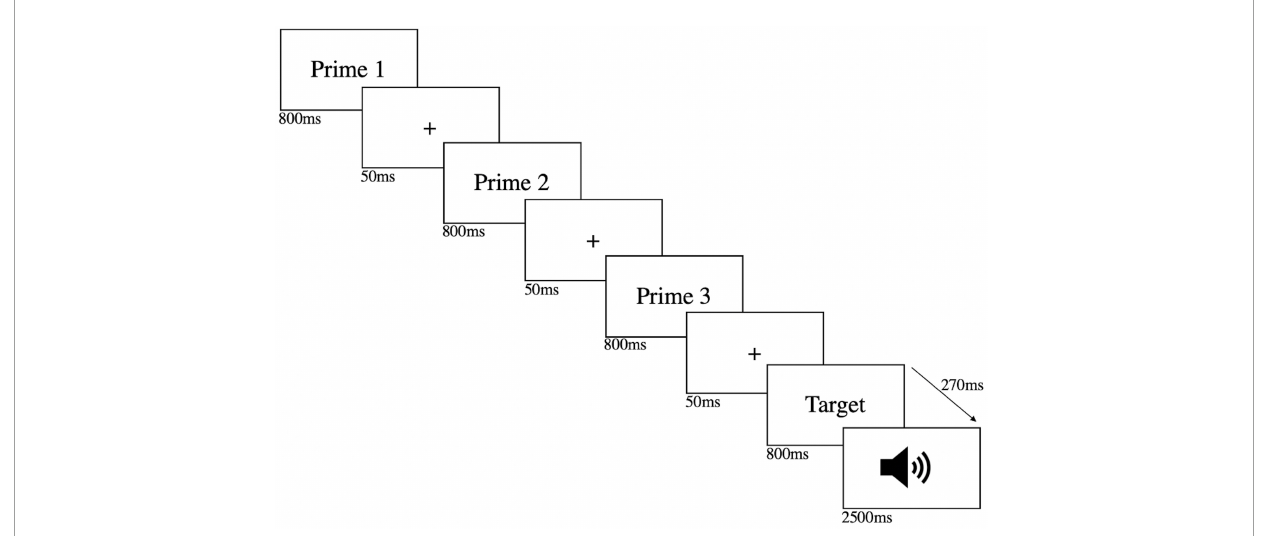
FIGURE1 Schematic illustration of an experimental trial in the SLIP-task. Participants are shown three phonological primes before being presented with a target-cued pair (i.e., the spoonerism eliciting-pair) they have to read out loud.